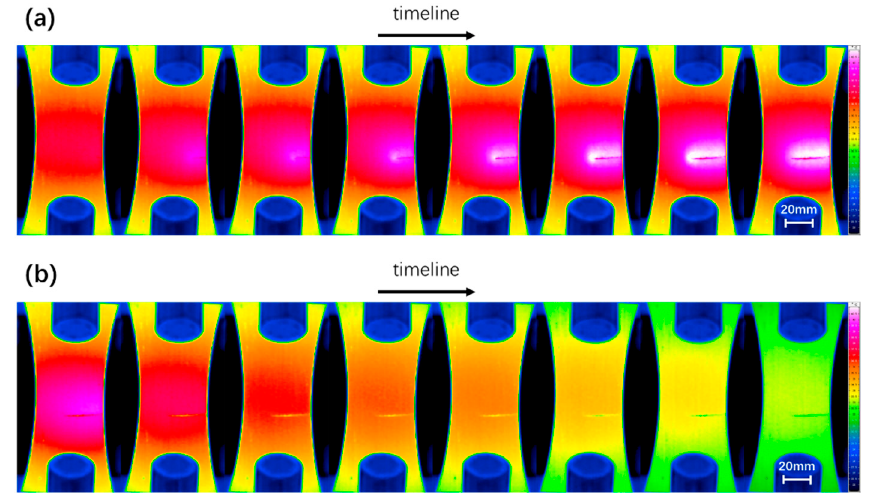
Figure 8. A series of thermal images of ( a ) the macro crack propagation and ( b ) the natural cooling after final failure.